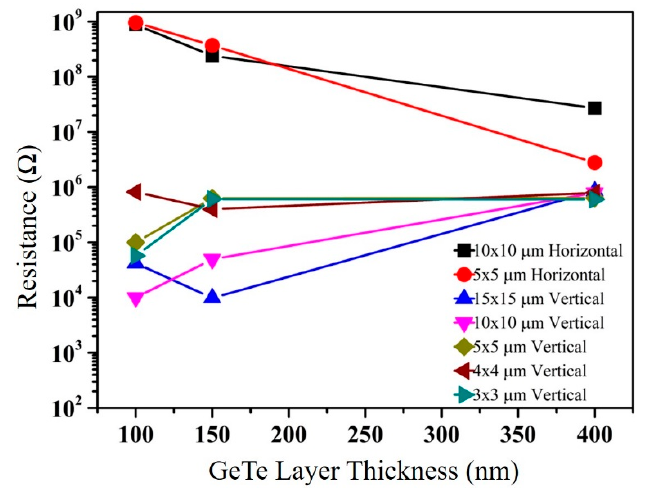
Figure 3. Amorphous phase resistance versus GeTe layer thickness plot for vertical and horizontal resistors.